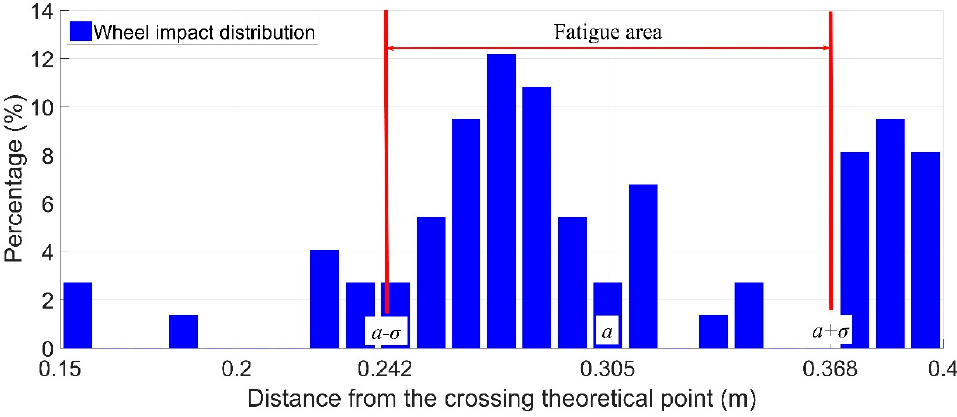
Figure 9. Example of fatigue area calculation.